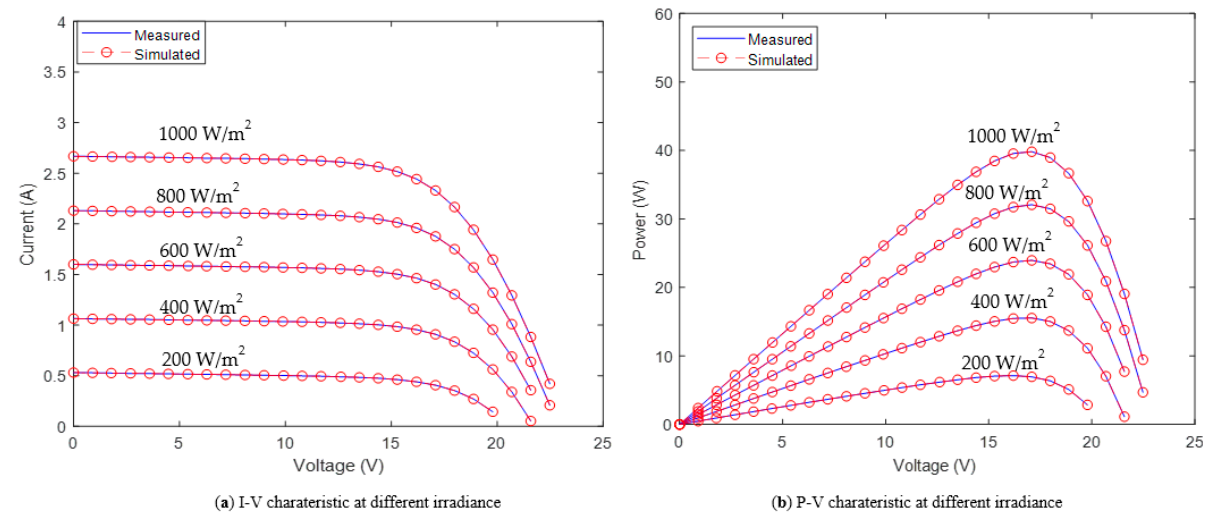
Figure 15. Depiction of error value between all I measured and estimated data on SDM for SM55 module at different irradiance.